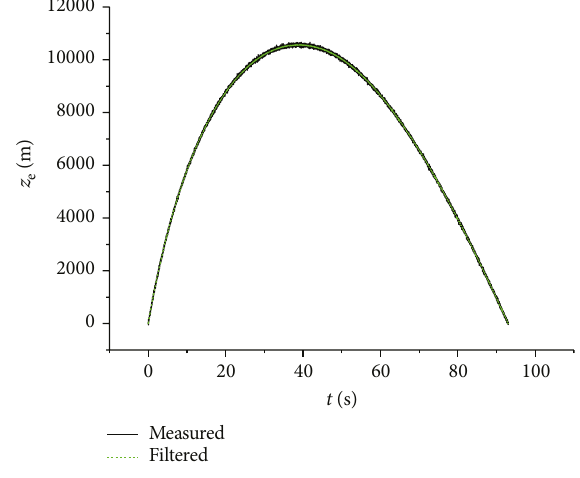
Figure 10: Coordinate z